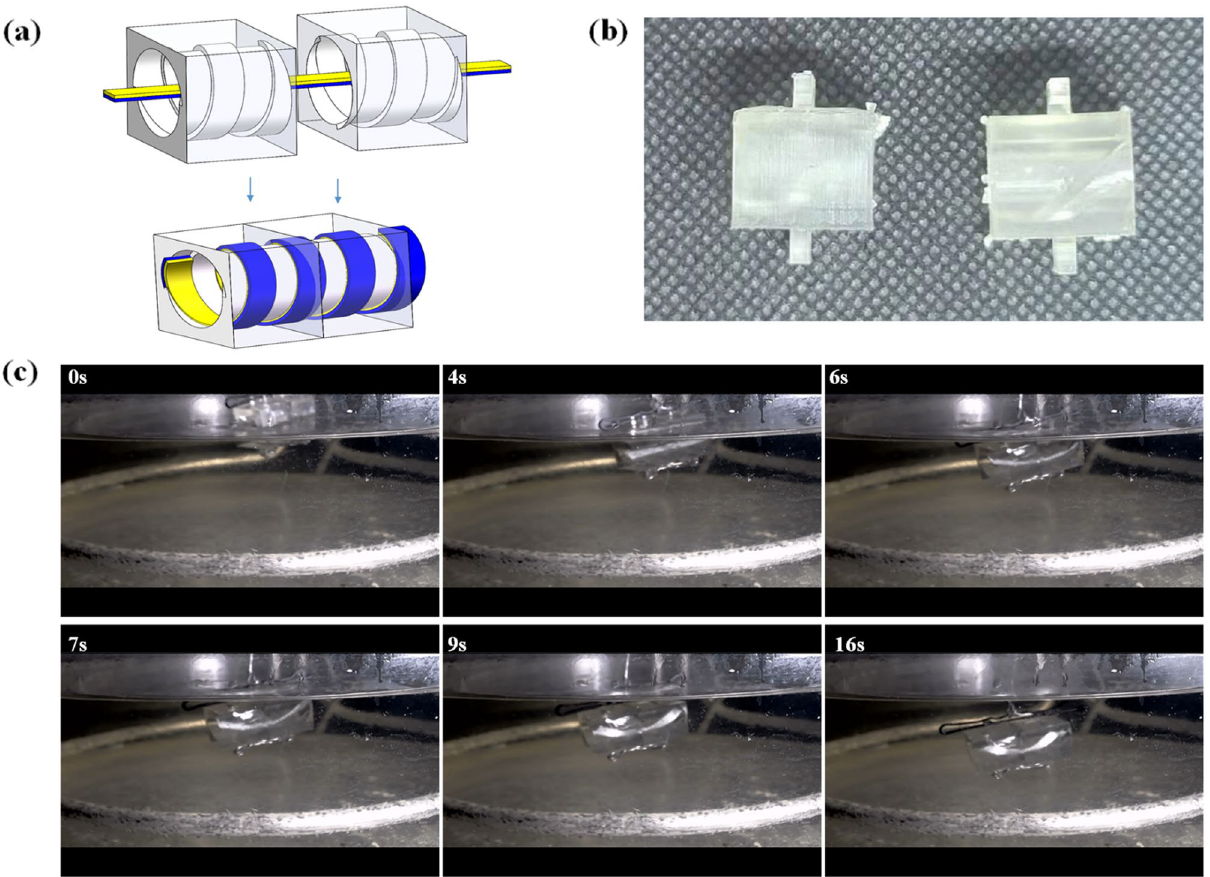
Figure 8. ( a ) Self-assembly schematic; ( b )two bonding structures; and ( c ) articulation